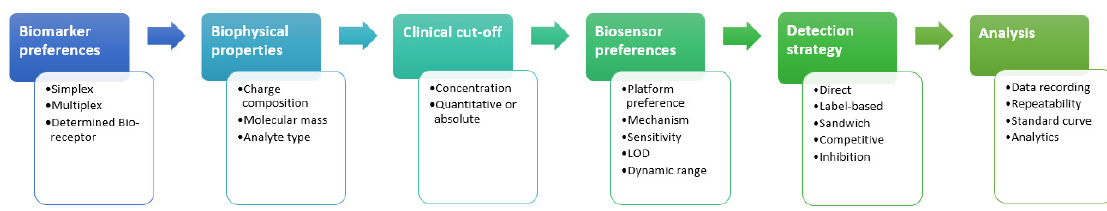
Figure 12. The main steps to be considered in the development of a diagnostic tool from biomarker selection, analysis of the biophysical properties, clinical cut-off overview, biosensor preferences, and detection strategy to data analysis.